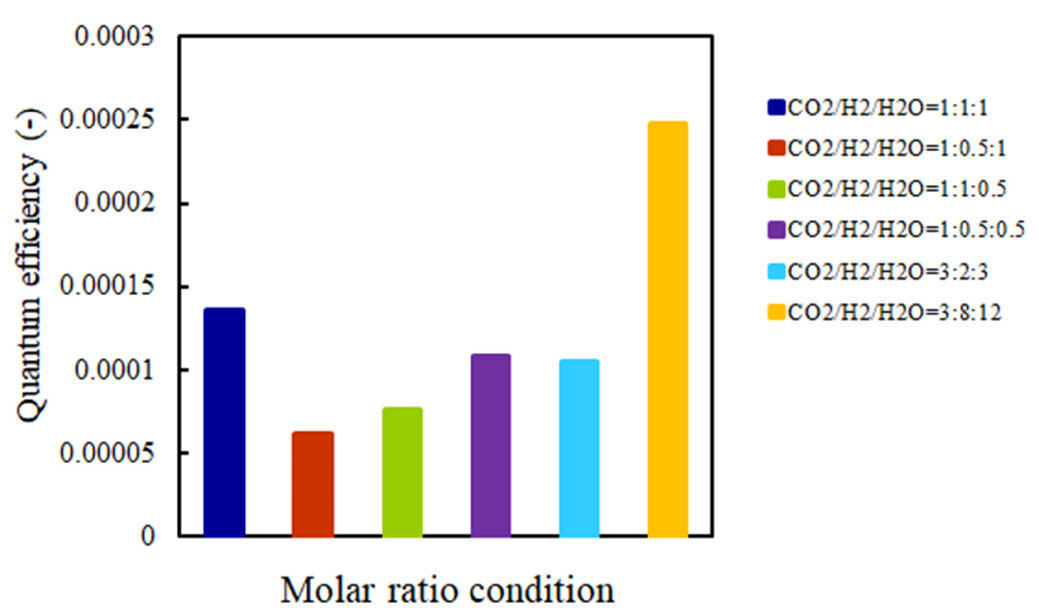
Figure 9. Comparison of quantum efficiency among different molar ratios without UV light. The pulse number is 200. The highest quantum efficiency is obtained under the condition of the molar ratio of CO 2 /NH 3 /H 2 O = 3:8:12.